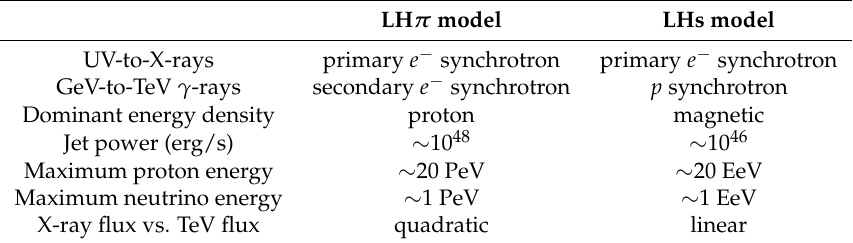
Table 1. Comparison of the hadronic model variants LH π and